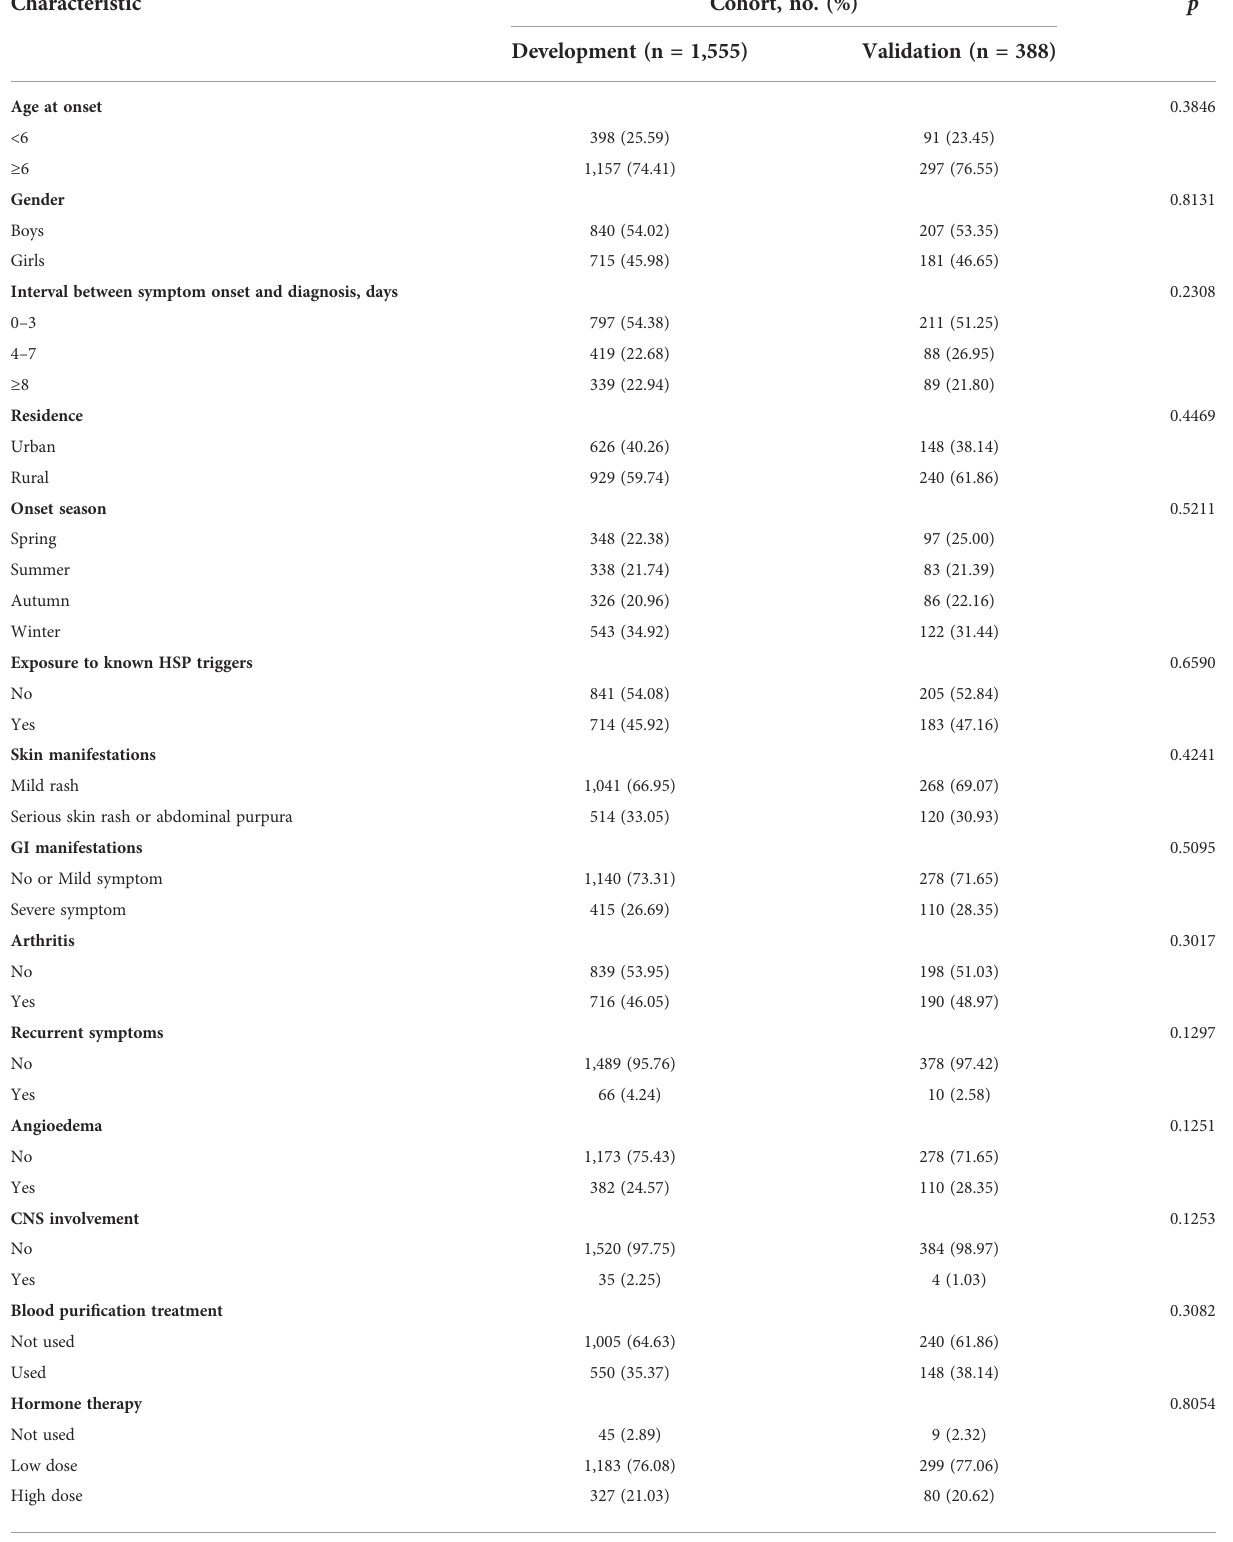
TABLE 1 Clinical and characteristics of development and validation cohort patients undergoing